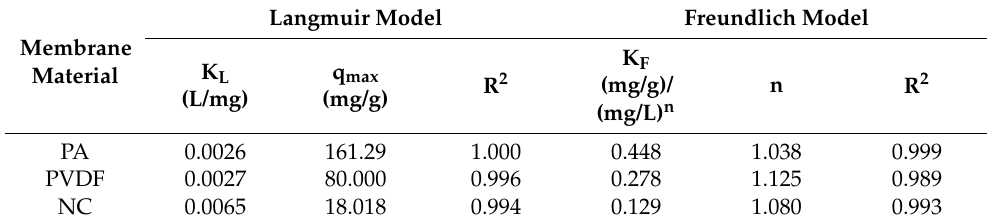
Figure 3. The isothermal adsorption model fitting of Langmuir ( a ) and Freundlich ( b ) for the adsorption of BPA onto three MFMs. Table 3. The isothermal adsorption constants of BPA by three MFMs.